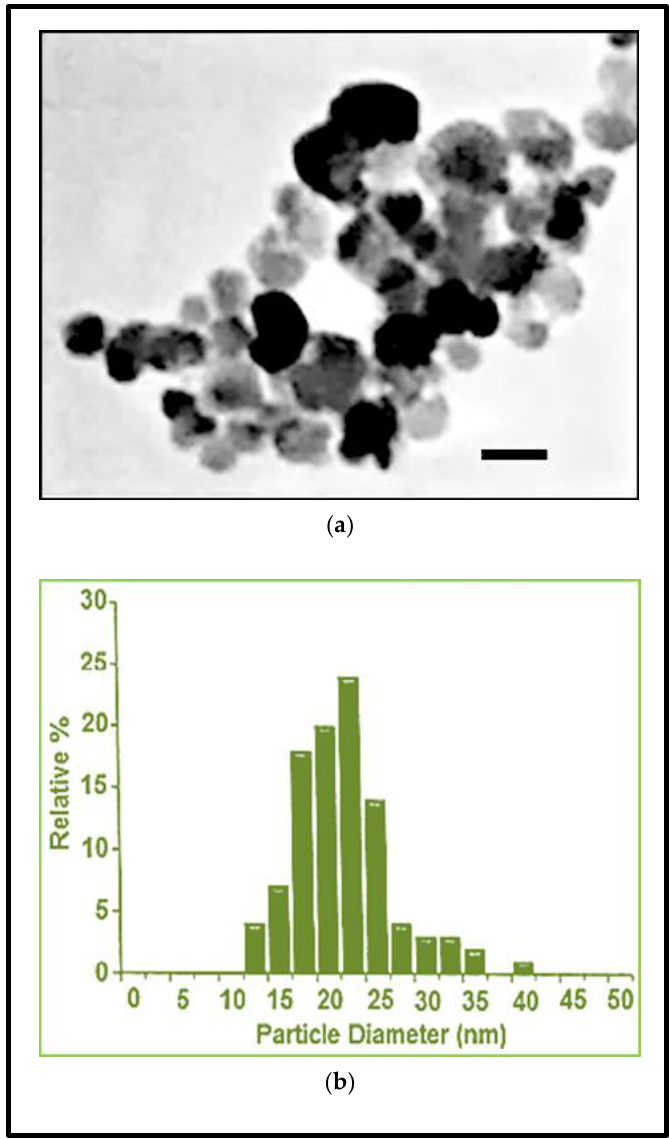
Figure 1. Fe 3 O 4 NPs stock suspension. ( a ) Morpho-dimensional analysis by transmission electron microscopy. Scale bar: 20 nm; ( b ) hydrodynamic diameter evaluation by dynamic light scattering measurements (data provided by nanoComposix Company).